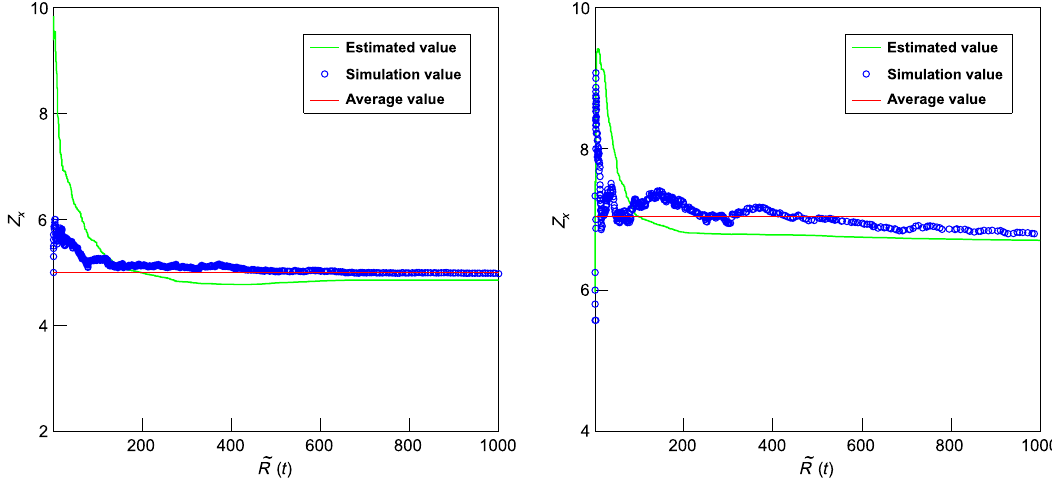
FIG. 10. Estimates for the value of Z x for the binomial (left) and exponential (right) networks, when (cid:1) i and (cid:1) r are known. The red line and green curves correspond to the average and the estimated excess